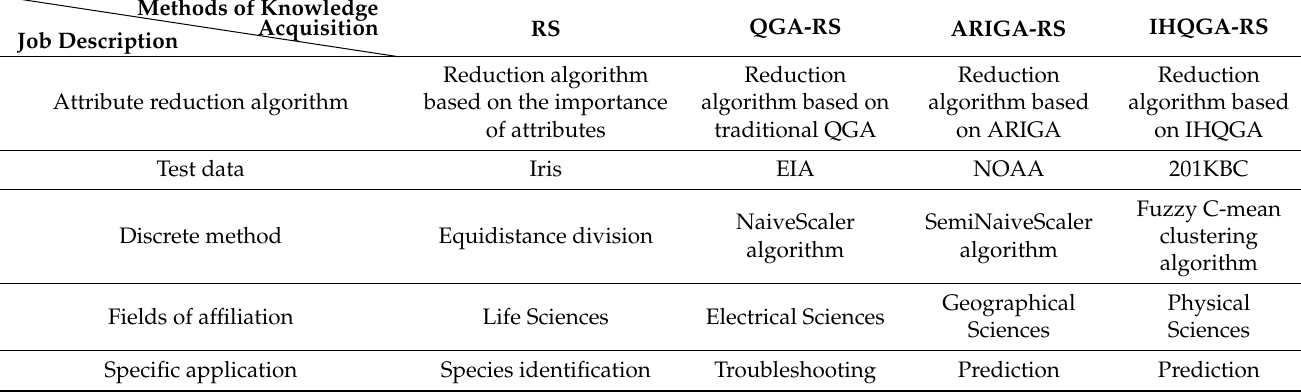
Table 10. Comparison of the work content of several knowledge acquisition methods.